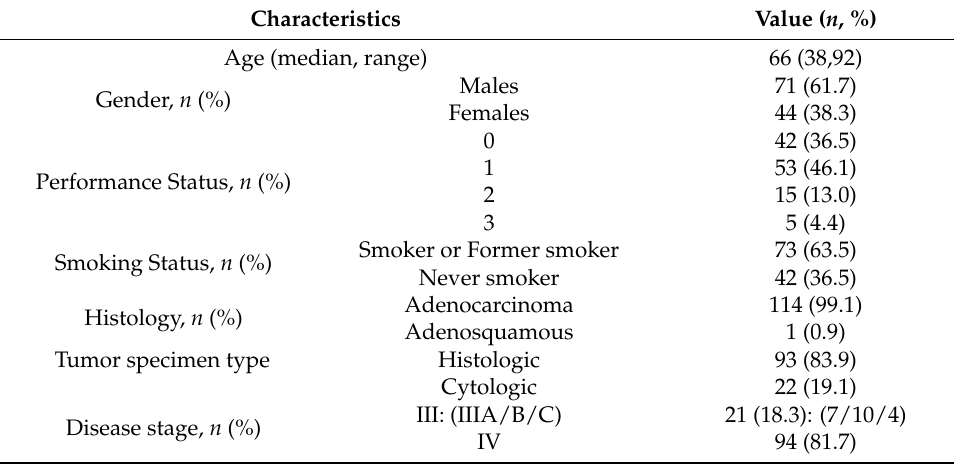
Table 1. Patient’s demographics and clinical